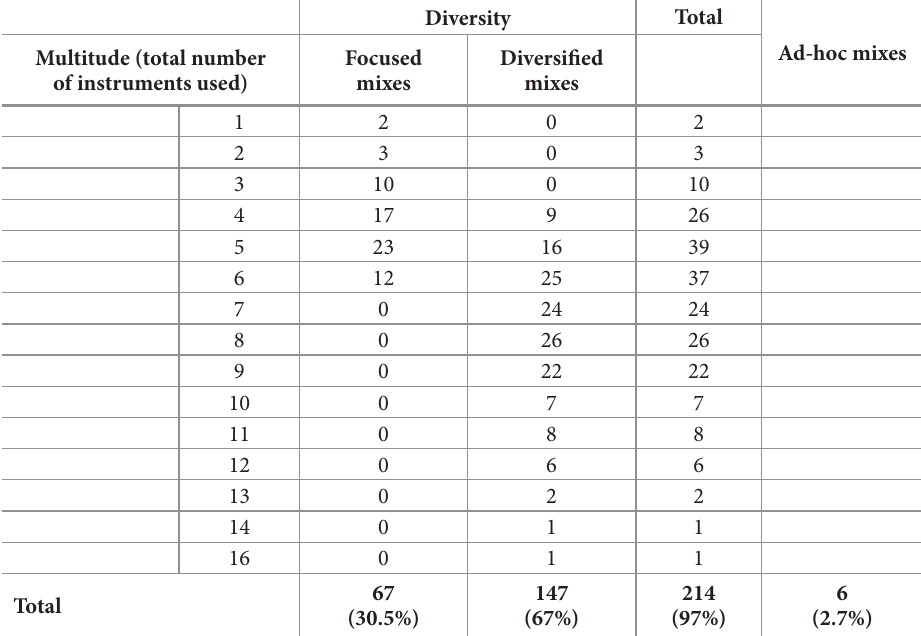
ad-hoc mixesmultitude (total number